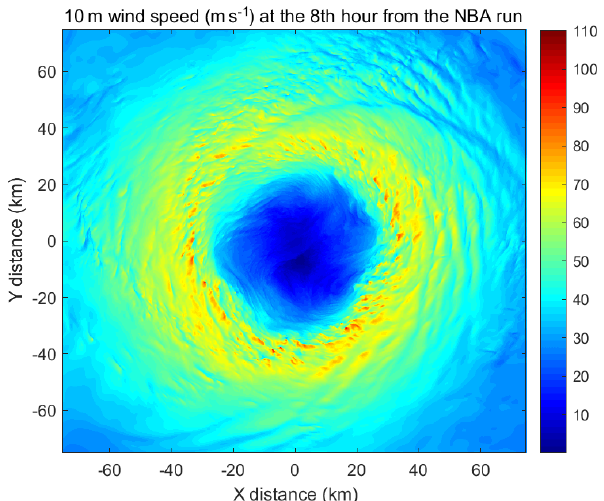
Figure 3. Instantaneous 10m surface wind speeds of Hurricane Is- abel (2003) at the 8th simulation hour by a WRF LES that uses the 3-D NBA SGS